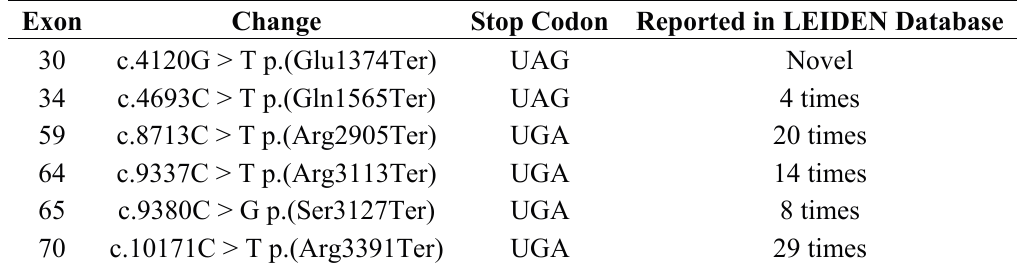
Figure 2. The mutation profile of Mexican-Mestizo patients. The horizontal bars represent the exons involved in mutations: deletions ( blue ), duplications ( red ) and point mutations ( green ). Table 1. Point mutations found in Mexican-Mestizo DMD patients.